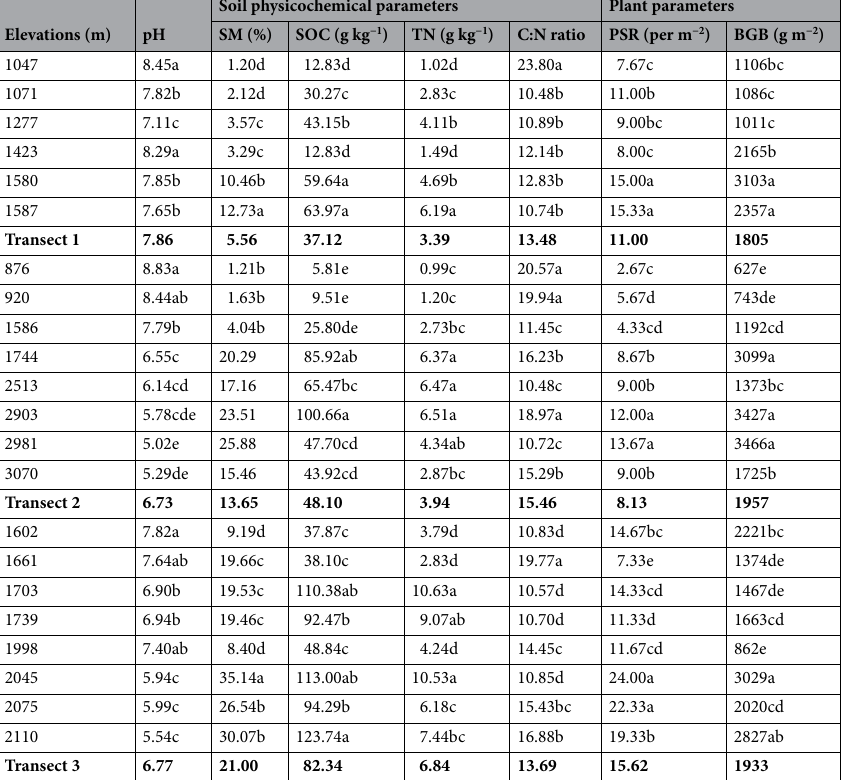
Table 1. Soil properties and plant variables at different sampled elevations. SM soil moisture, SOC soil organic carbon, TN total nitrogen, PSR plant species richness, BGB belowground biomass. Values in bold indicate the mean value in the indicated